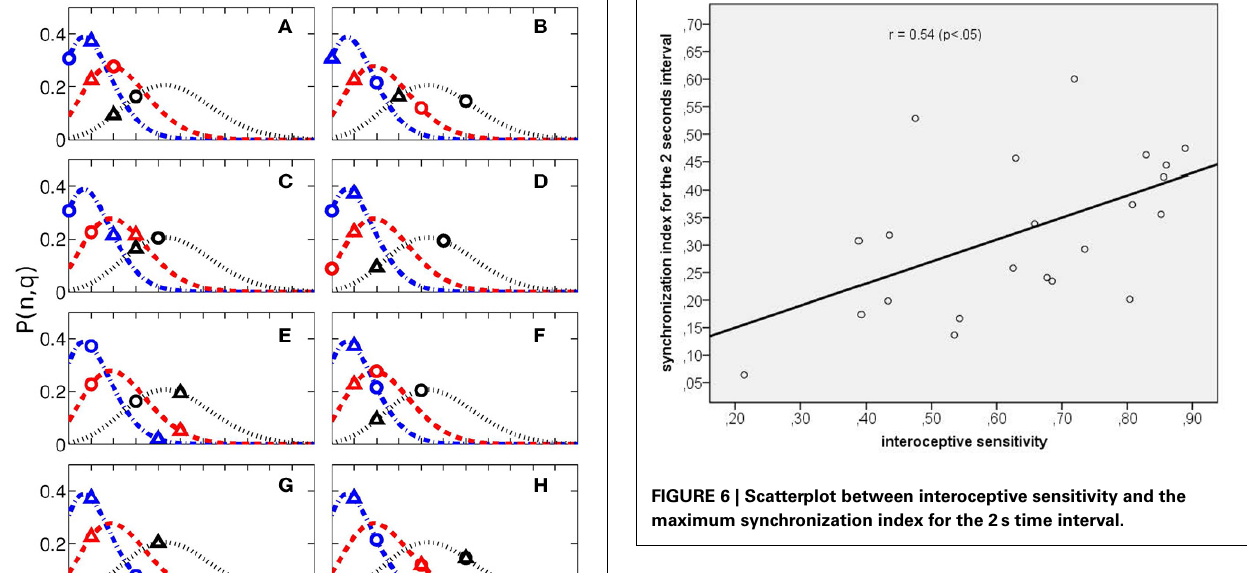
processes for the shorter time range of 2 s. It is an important